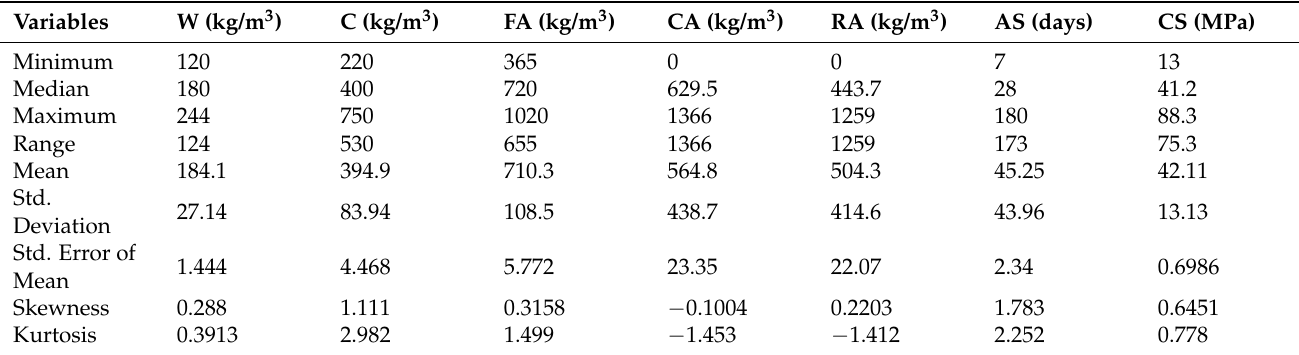
Table 1. Statistical measures of inputs and outputs in this